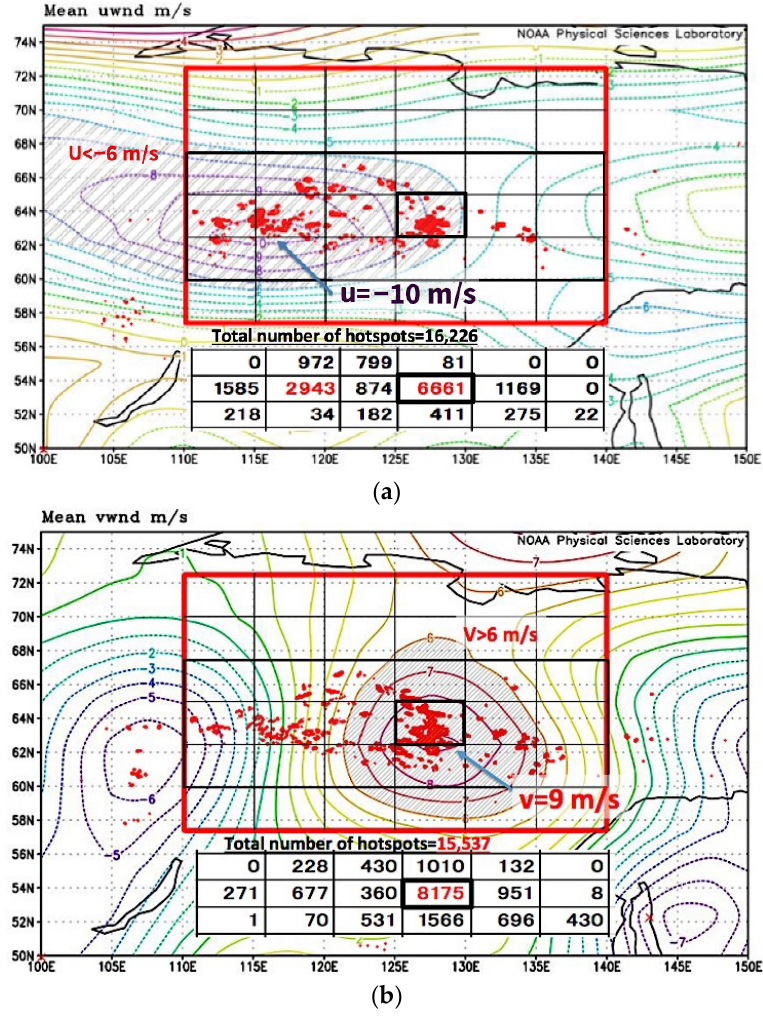
Figure 9. ( a ) U-wind map on 2 August. The symbol “-” means easterly wind. Inserted table shows number of HSs in central blocks of Sakha. See captions for Figure 4, ( b ) V-wind map on 7 August. The symbol “+” means southerly wind. Inserted table shows number of HSs in central blocks of Sakha. See captions for Figure